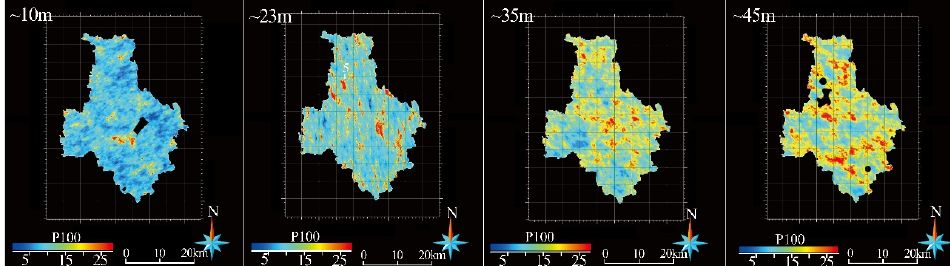
Figure 17. Diagrams of E s values at varying depths (10 m, 23 m, 35 m, and 45 m, respectively) derived from the 3D property model.